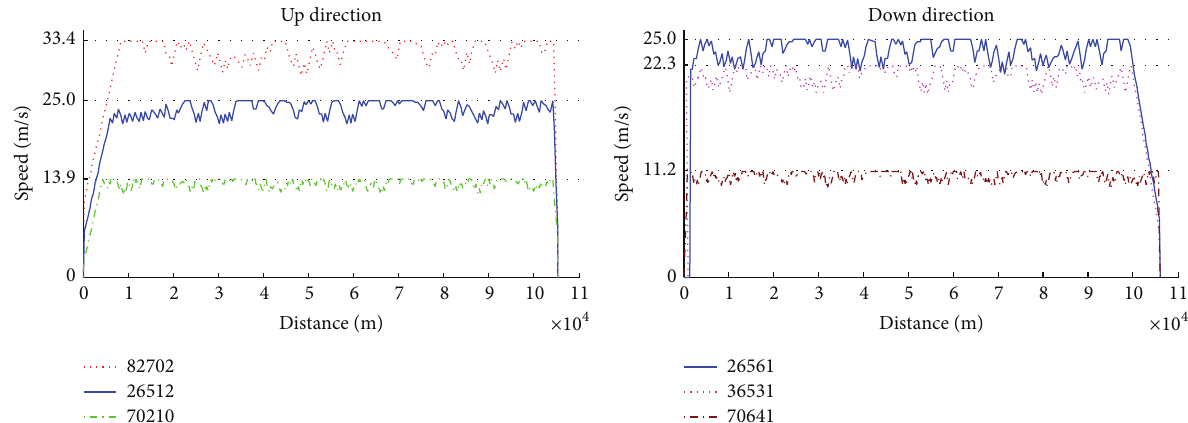
Figure 5: Train speed-distance curve (NCBS: blocking section 5 in the